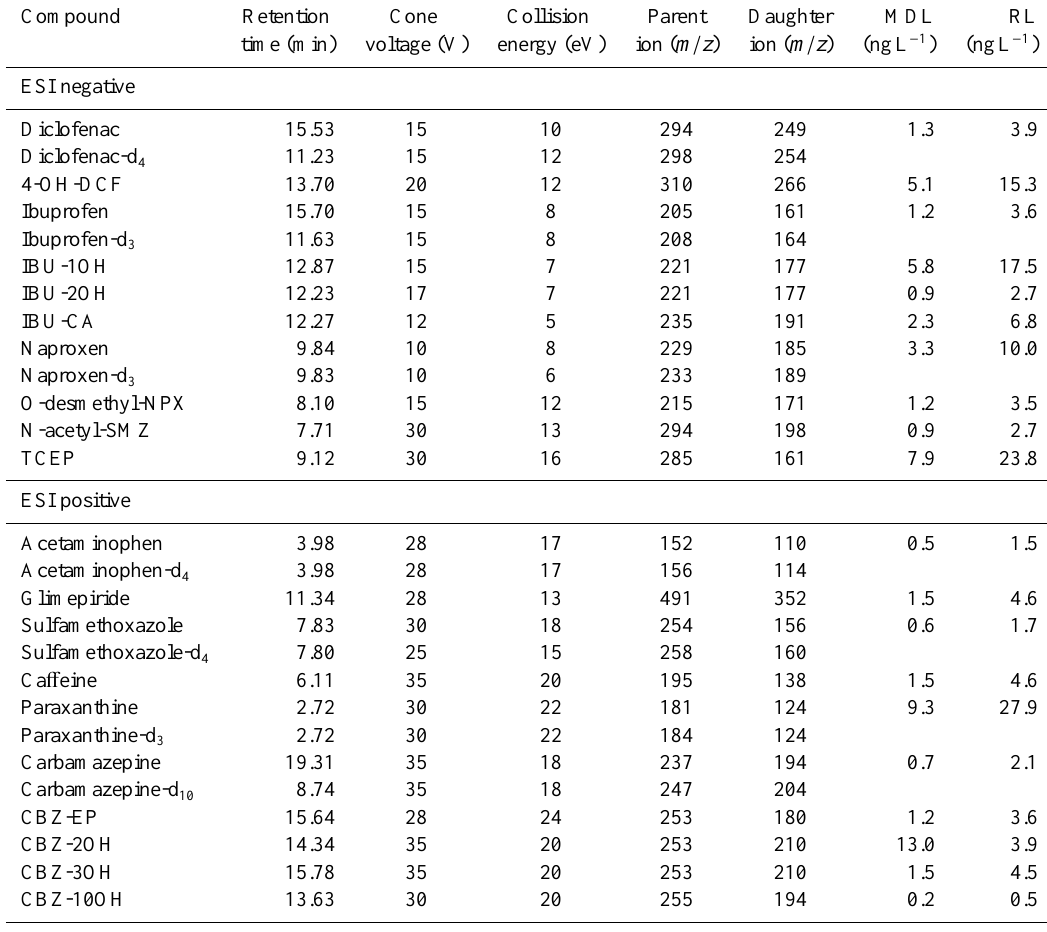
Table 2. Analytical parameters of selected compounds (MDL: method detection limit; RL: reporting limit). Compound